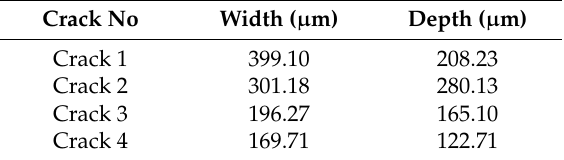
Table 2. The size of the simulated cracks on the LMD-316L austenitic stainless-steel sample.